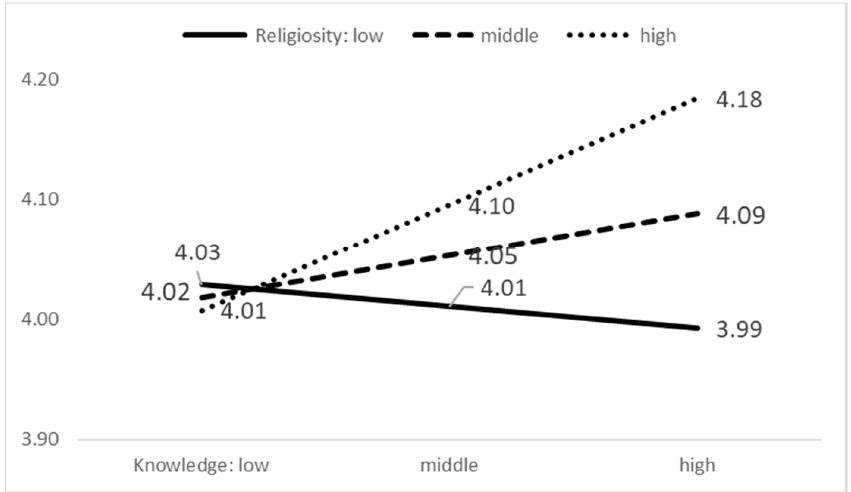
Figure 10. Knowledge (IV) × religiosity (M) = skepticism (DV).